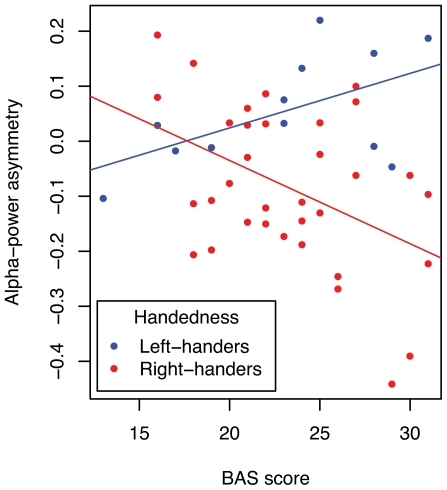
Associations between alpha power asymmetry and approach motivation in right- and left-handers.Asymmetries in ln-transformed alpha power are plotted for each subject as a function of BAS score. Asymmetry scores plotted here were computed as: (Left-hemisphere−Right-hemisphere)/(Left-hemisphere+Right-hemisphere). More positive values denote higher left hemisphere alpha power (and therefore less activity in the left hemisphere than in the right hemisphere). Alpha power for this plot was measured at the electrodes circled in fig. 1.